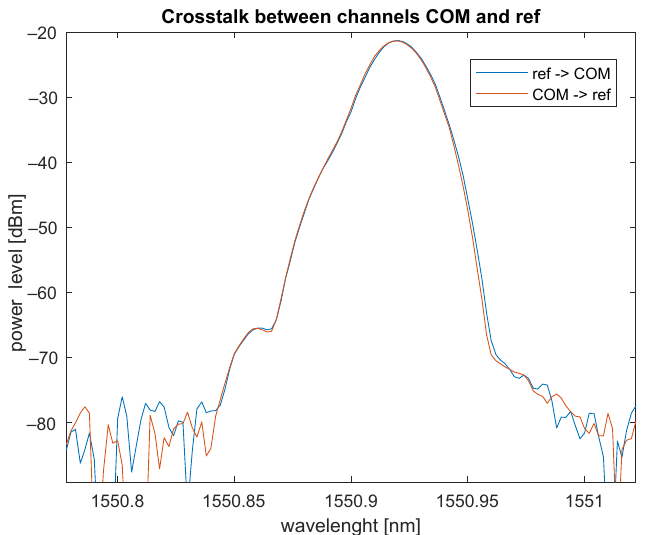
Figure 12. Crosstalk (islolation) between REF and COM ports in CWDM